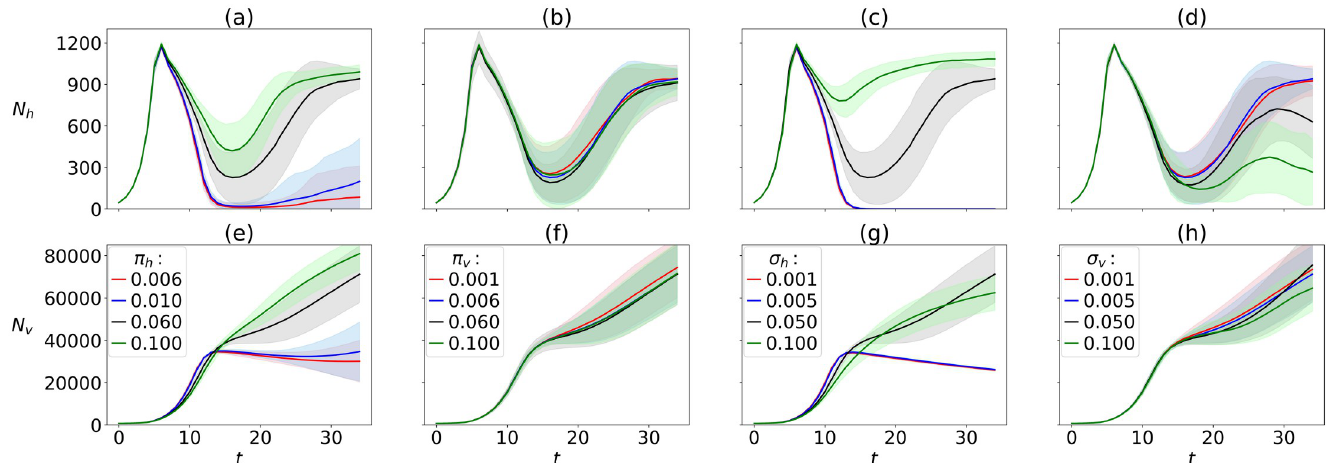
Fig 5. Model’s sensitivity to evolution in organism traits. Sensitivity of host (a-d) and virus dynamics (e-h) to mutation probability in host traits ( π standard deviation in mutation for host traits ( σ h ) and standard deviation in mutation for virus traits ( σ v ). Plotted curves: ensemble averages from 100 runs lasting T = 36 h, with standard deviations shown as